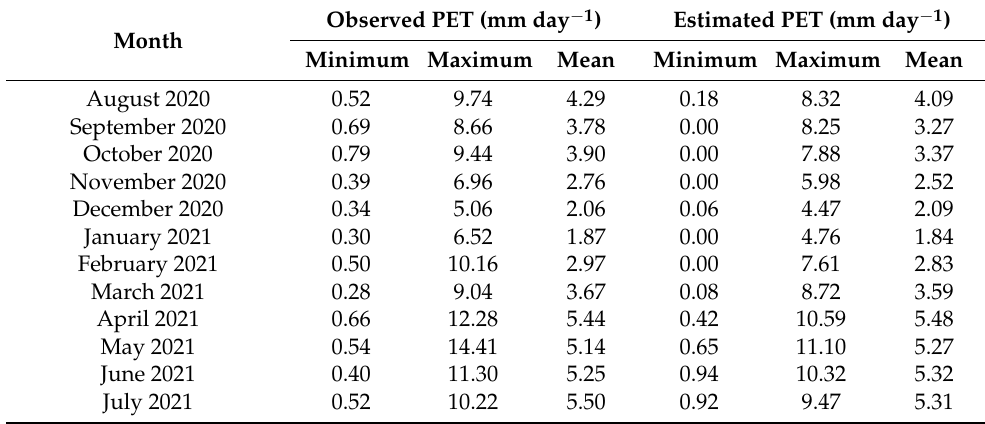
Table 4. Comparison of observed PET and GK2A/AMI satellite-derived PET estimates.